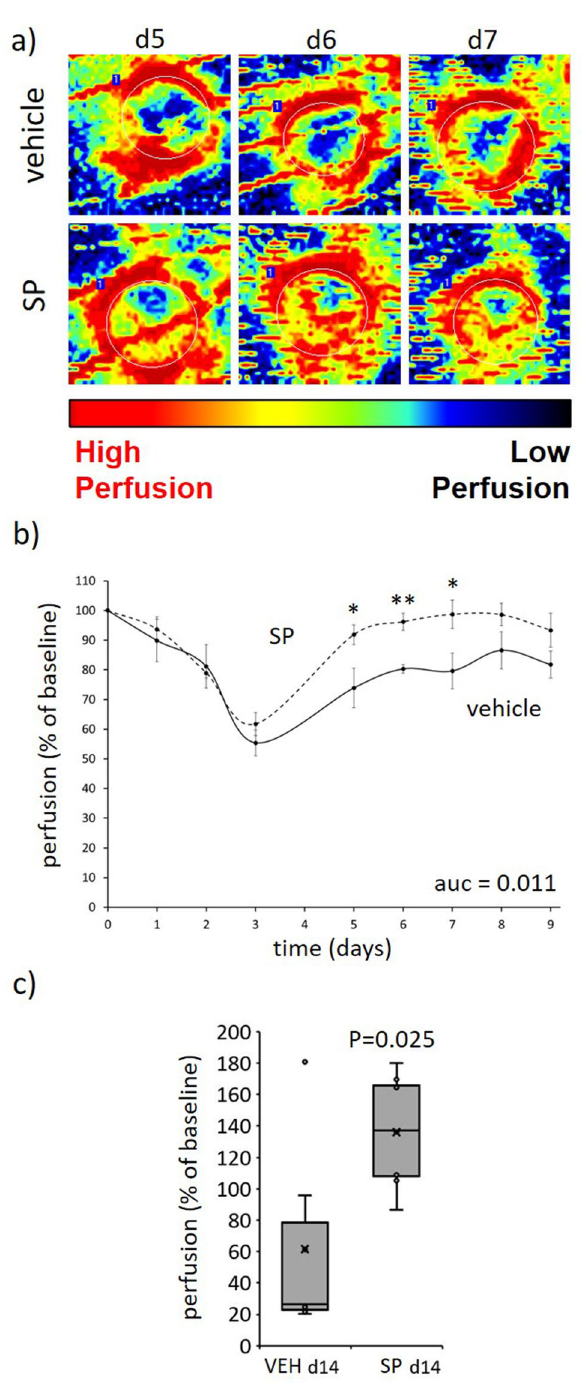
Figure 4. SP improves tissue perfusion post-injury. ( a ) Representative Doppler images of SP-treated pressure injury tissue. Region of interest (ROI) indicated by white dotted lines. ( b , c ) Quantification of tissue perfusion in ROI. Data presented as perfusion per unit area, mean ± SEM ( b ) or as box and whisker plot at d14 ( c ), n = 6. * P < 0.05, ** P < 0.005. Data analyzed by two-way ANOVA with Bonferonni post-hoc test. Auc = area under the